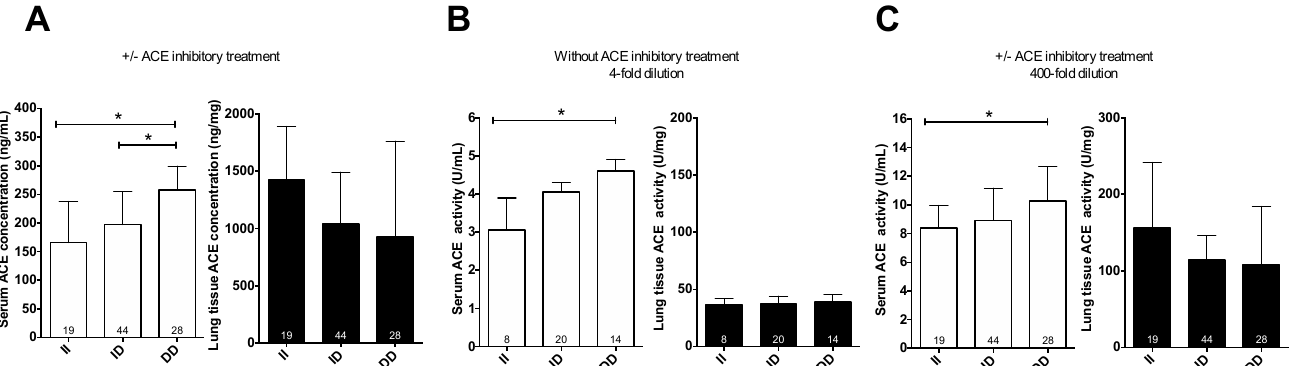
Figure 2. Missing effect of genotype on lung tissue ACE activity and expression. The ACE concentration was determined by ELISA in sera and lung tissue samples of patients ( A ). The label “+/ − ACE inhibitory treatment” means that patients with ACEi medication were included in the analysis. ACE activity in patients without ACE inhibitory medication at low dilution levels is shown in ( B ). ACE activity was also plotted at sufficiently high dilution levels (400-fold), where the ACE inhibitory drug had a negligible effect, to include all patients ( C ). Empty bars show serum concentrations ( A ) or activities ( B , C ), while filled bars represent lung tissue concentrations ( A ) and activities ( B , C ). Bars show the median, error bars represent IQR. Numbers within the bars indicate the number of biological replicates (patient samples) in the groups. Genotypes are indicated below the bars. Significant differences ( p < 0.05) are shown by the brackets and asterisks.